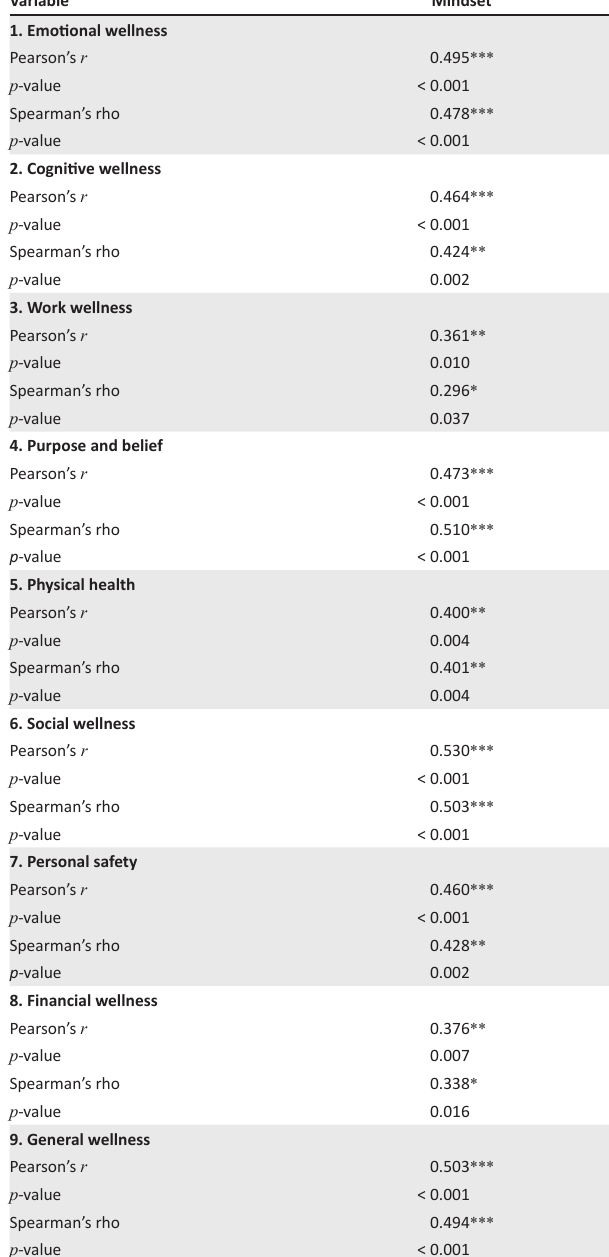
TABLE 3: Mindset and wellness factors.